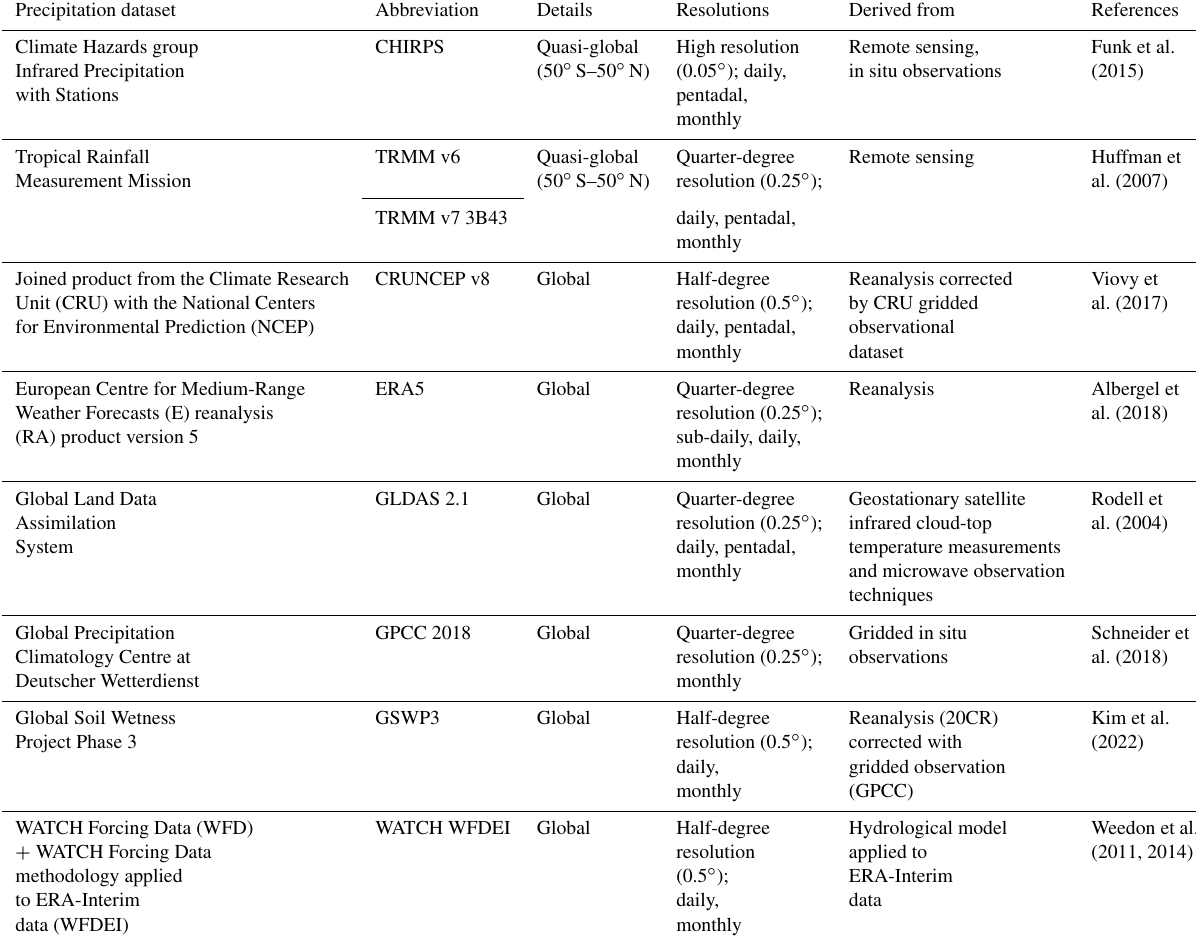
Table 1. Overview of the 10 precipitation datasets used in our study. Columns show the name of the dataset, the official abbreviation, the short abbreviation used here, the spatial and temporal resolution, and the